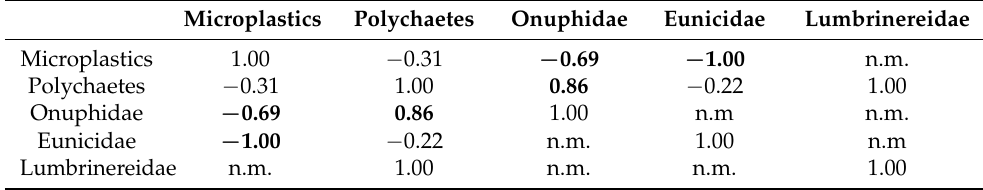
Table 4. Gamma non–parametric correlations between microplastics and polychaetes with related families found as number of items per stomach from a sample of the hollow–snout grenadier from the bathyal plane of the eastern central Tyrrhenian Sea. Bold values are significant p < 0.05 and n.m. stands for no match between data series concerned.